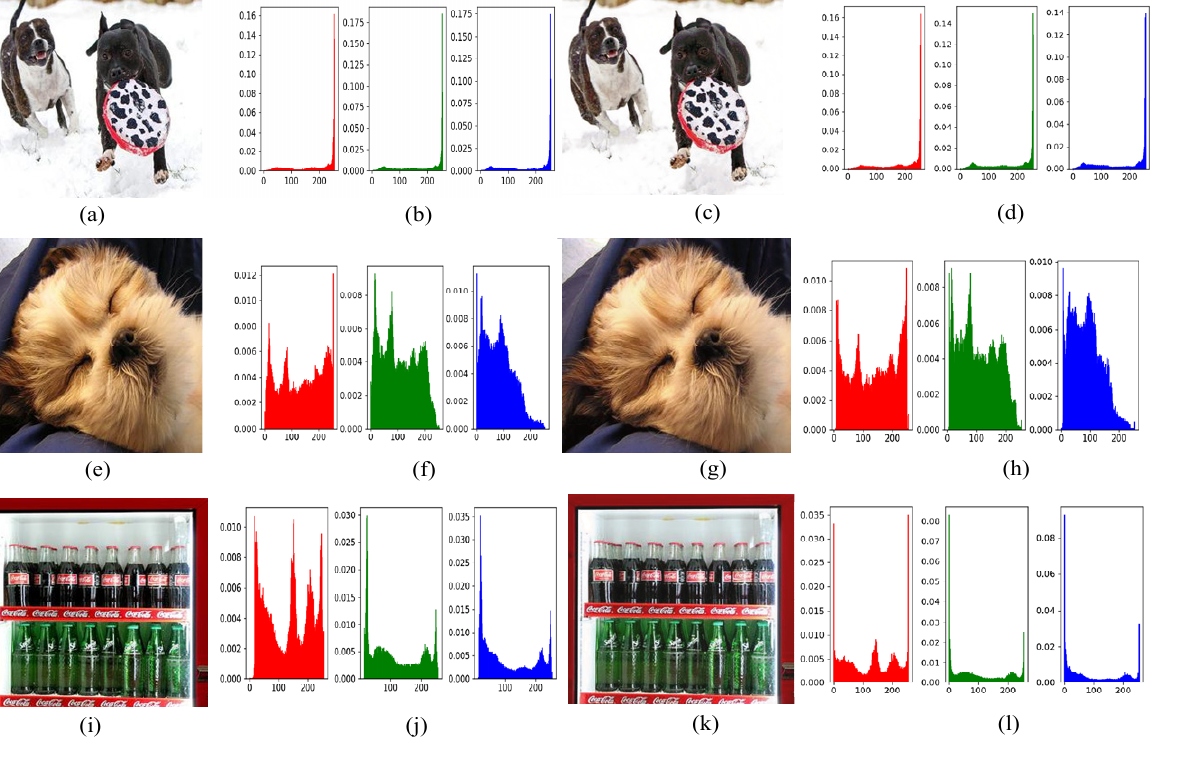
Figure 11. Image histograms for the three test images: ( a ), ( e ), and ( i ): original images; ( b ), ( f ), and ( j ): histograms of ( a ), ( e ), and ( i ) for the three (RGB) channels, respectively; ( c ), ( g ), and ( k ): reconstructed images; ( d ), ( h ), and ( l ): histograms of ( c ), ( g ), and ( k ) for the three (RGB) channels, respectively, when scale = 1.